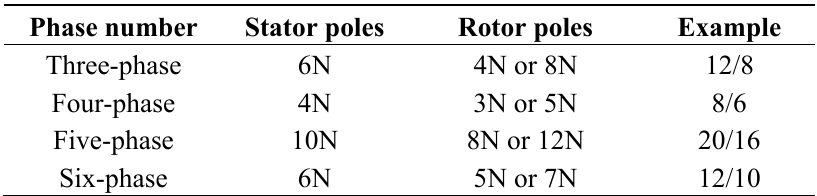
Table 1. The poles combinations of the